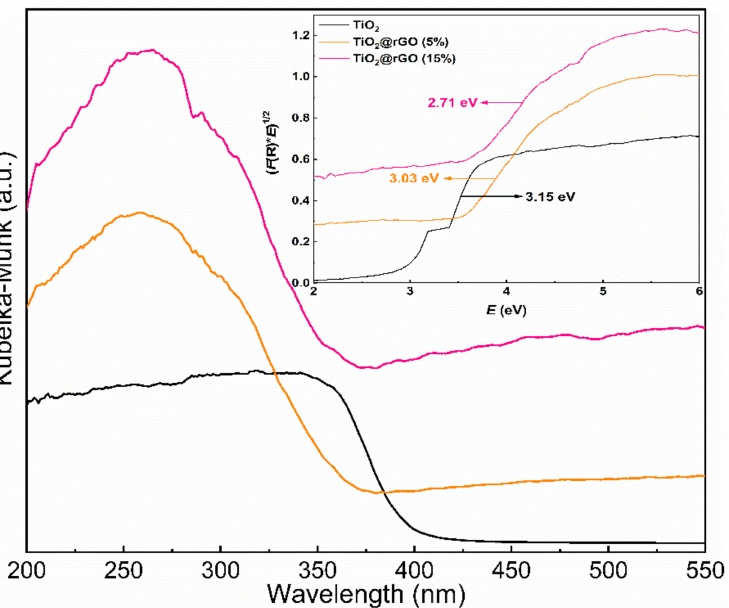
Figure 6. The absorption threshold energy (inset shows the bandgap energy) of synthesized pure TiO 2 particles and nanocomposites TiO 2 @rGO with 5 wt% and 15 wt.% of rGO thermal treated at 300 ◦ C.